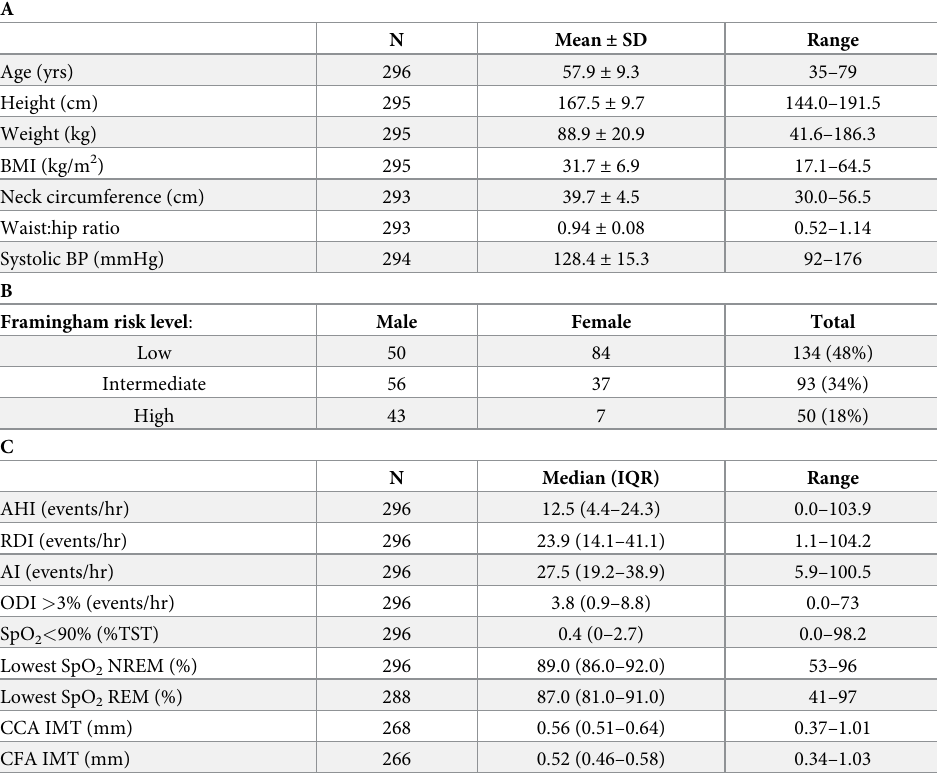
Table 1. Main group demographics and sleep disordered breathing status. Demographics (A), cardiovascular risk status (B), IMT and SDB status (C) of the Main Group, presented as mean ± SD, median (IQR) or frequency, where appropriate, plus range. See text for